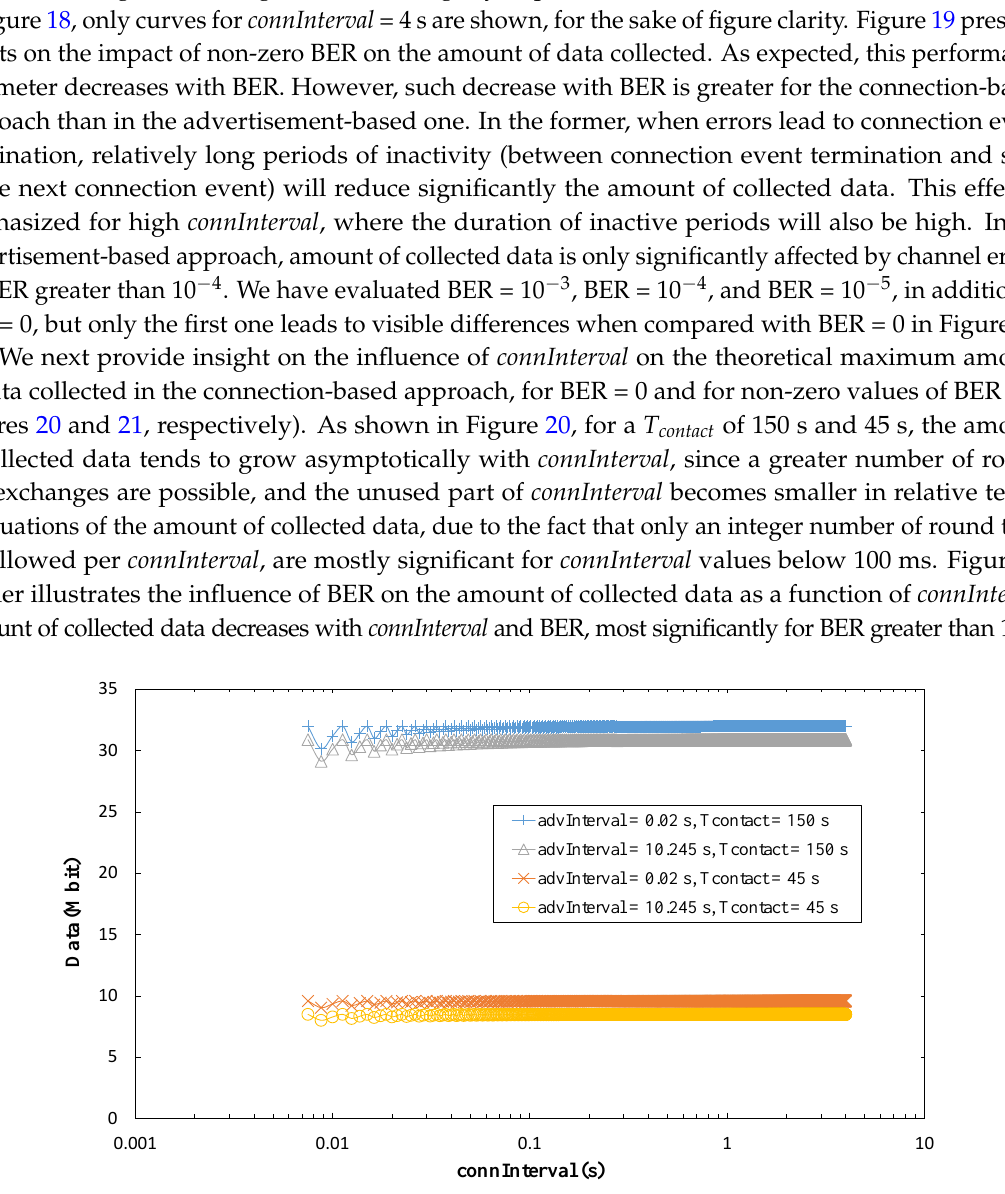
Figure 20. Influence of connInterval on the maximum amount of collected data per contact interval, for the connection-based approach, and for different T contact and advInterval values.